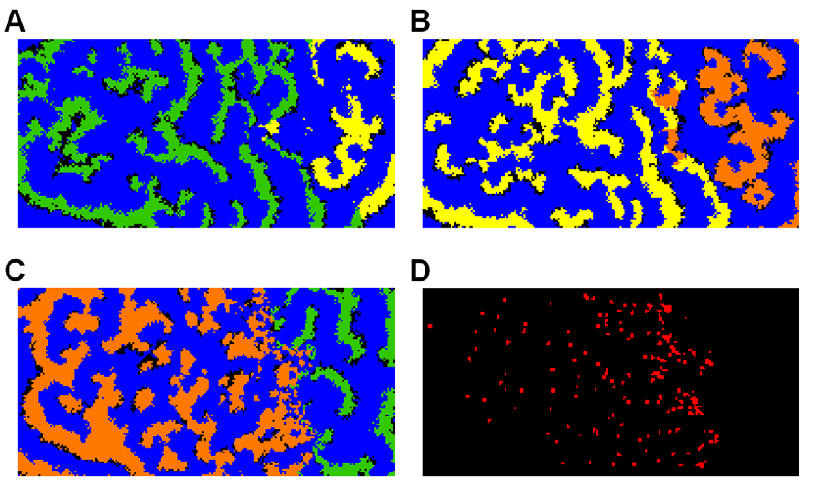
Figure 1. Rock-scissor-paper cyclic dominance. A: After 50 time units, infection period t I =0.4 (green) is winning against t I =0.6 (yellow); black indicates susceptible individuals and blue is resistance. B: After 50 time units, t I =0.6 (yellow) is winning against t I =0.8 (orange). C: After 250 time units, t I =0.8 (orange) is winning against t I =0.4 (green). D: Local extinction of pathogens in Fig. 1C. Here, cells are colored red if they persistently have been in direct contact with the disease during the last 10 time units; black cells indicate local extinction. All simulations are on a 201 6 100 field size with empty boundary conditions. Infectivity is set at b =32, and resistant period t R =1. For initial conditions a susceptible field is seeded with 100 randomly located 10 6 10 blocks of infected individuals and subsequently with 100 random (overlapping) 10 6 10 blocks of resistant individuals. Each competitor is introduced exclusively on one side of the field, and the middle vertical row is kept susceptible for the first 10 time units, in order to let the spatial patterns develop before the competition is started. For movies see supporting Videos S1, S2 and S3.